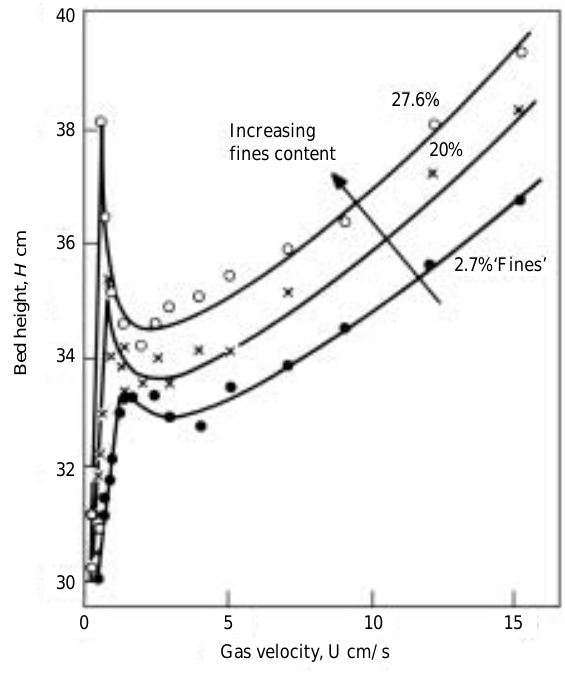
Fig. 4 Variation of fluidized bed height with superficial gas veloc- ity [6]